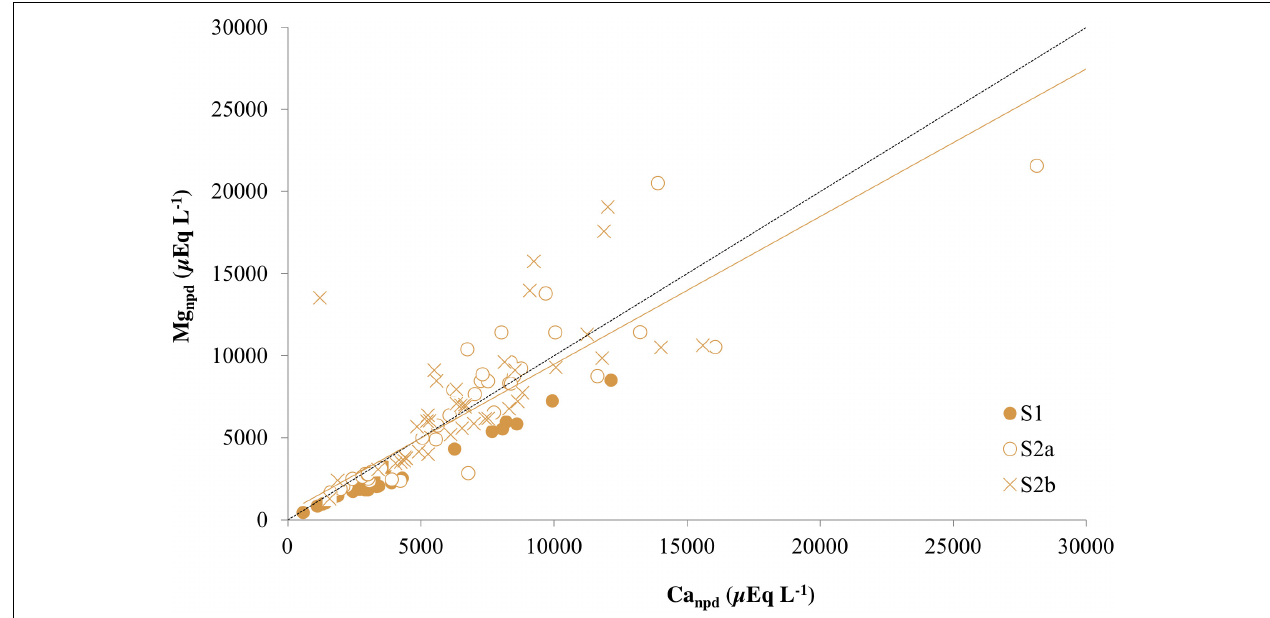
FIGURE 6 | Non-precipitation-derived magnesium (Mg npd ) and non-precipitation-derived calcium (Ca npd ) in the three cores from Ice Wedge South. The dashed black line corresponds to a 1:1 relationship between Ca npd and Mg npd that represents dolomite dissolution. The solid orange line is a regression for all points from the three cores from Ice Wedge South (R 2 = 0.69).